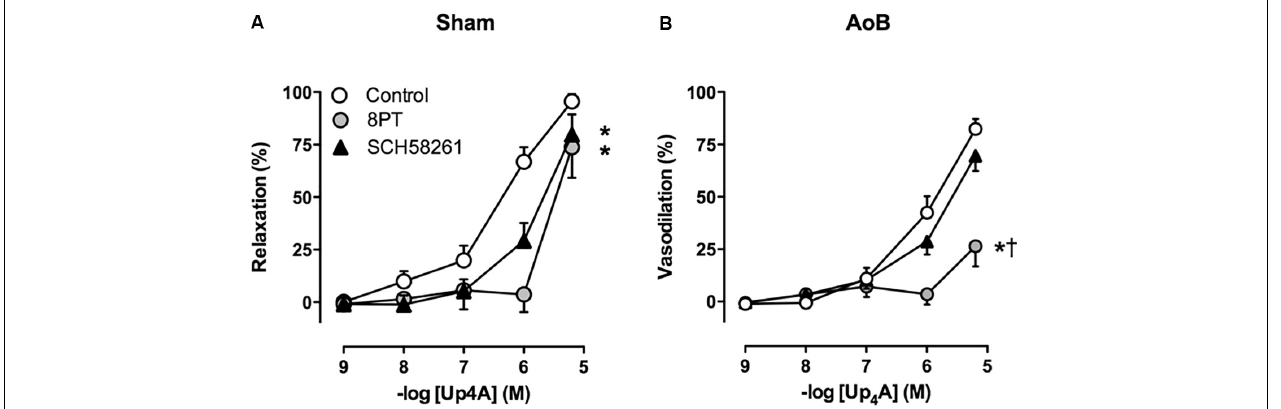
FIGURE 4 | P1 receptor blockade with 8PT attenuated relaxation to Up 4 A less in coronary small arteries from Sham-operated swine ( A , n = 6) as compared to coronary small arteries from swine with AoB ( B , n = 6). A 2A receptor blockade with SCH58261 attenuated Up 4 A-induced relaxation in coronary small arteries from Sham ( n = 5), but not AoB ( n = 5). Control data are the same as in Figure 2 (‘Sham’ and ‘AoB’). ∗ P < 0.05 effect of 8PT vs. corresponding control. † P < 0.05 effect of 8PT vs. corresponding SCH58261.